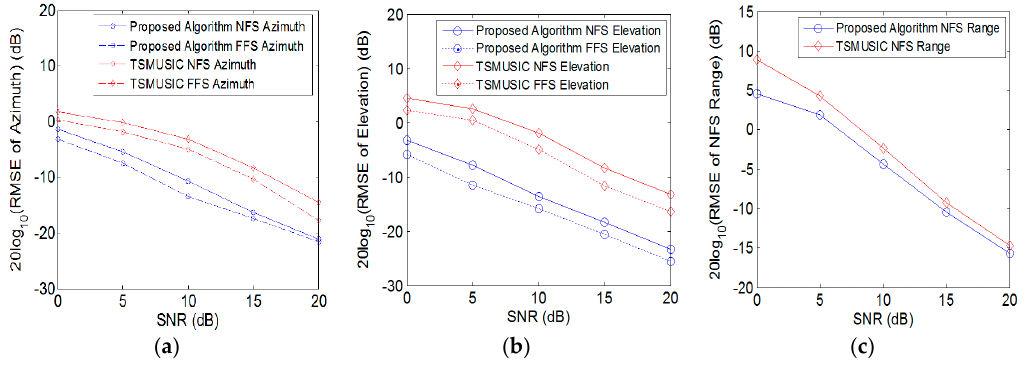
Figure 7. RMSEs versus SNR: ( a ) Azimuth angle; ( b ) Elevation angle; ( c ) Near-field source range.